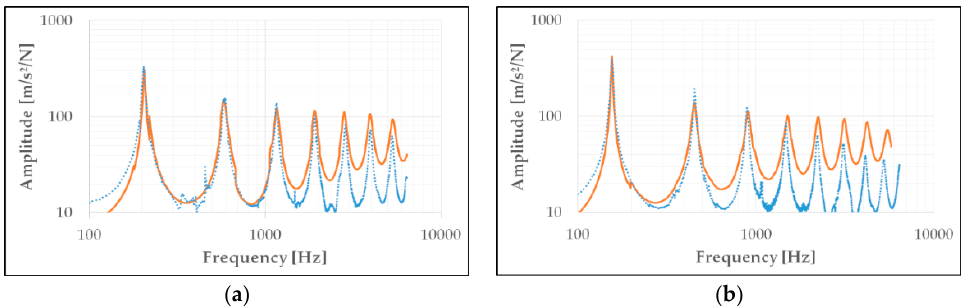
Figure 19. FRF of the simulation and the experiments of PA66 ‐ GF30 of the IF orientation at 23 °C and 50% rh ( a ) and 130 °C and 0% rh ( b ).